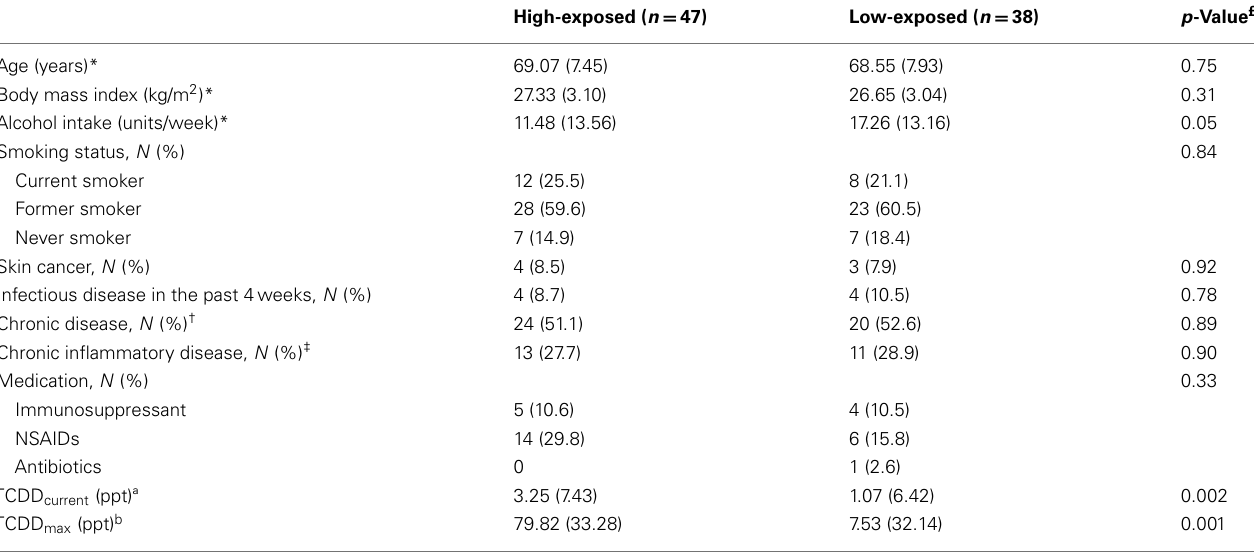
Table 1 | General characteristics of high and lowTCDD exposed